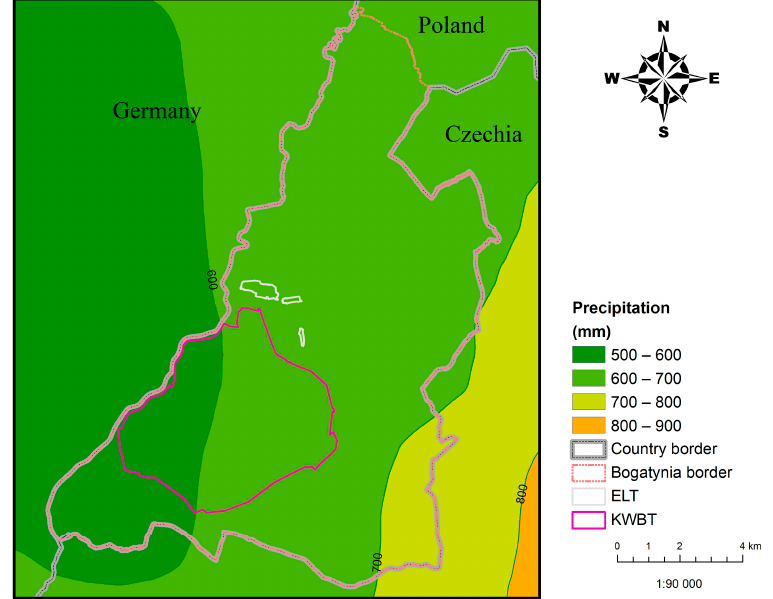
Figure 14. Spatial distribution of annual precipitation determined by the WRF/CALMET model in 2018 (source : own study).